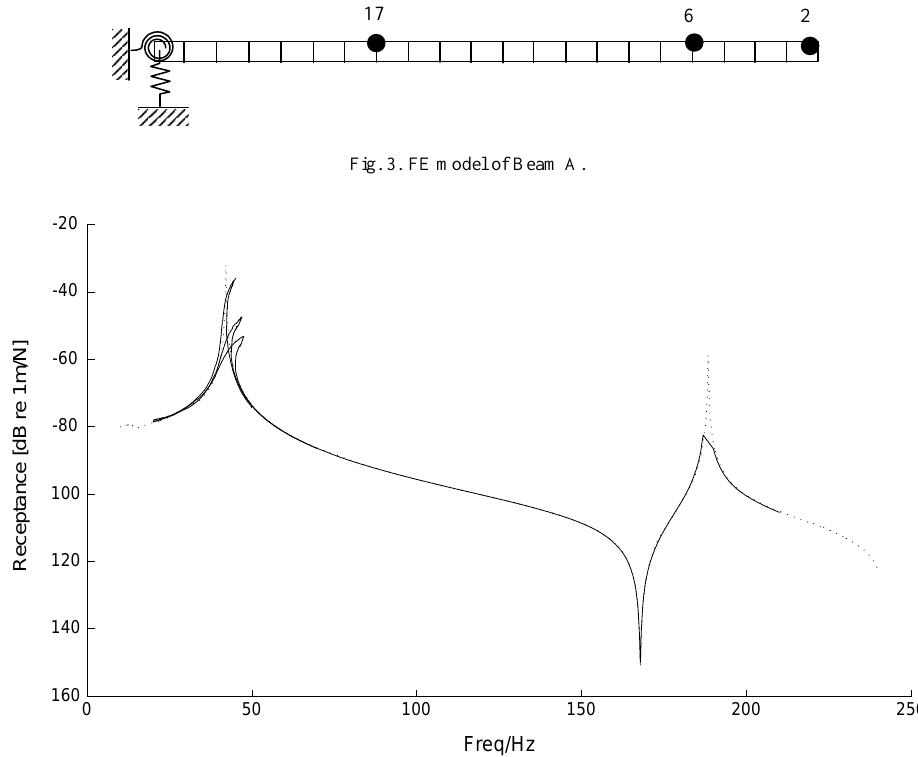
Fig. 3. FE model of Beam A.